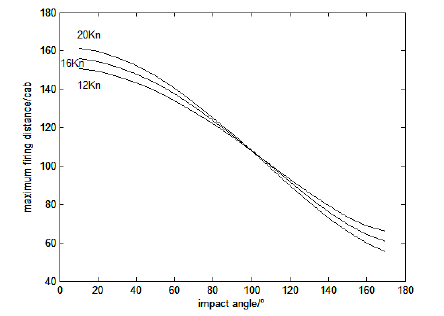
Fig. 5. The maximum firing distance of passive acoustic homing